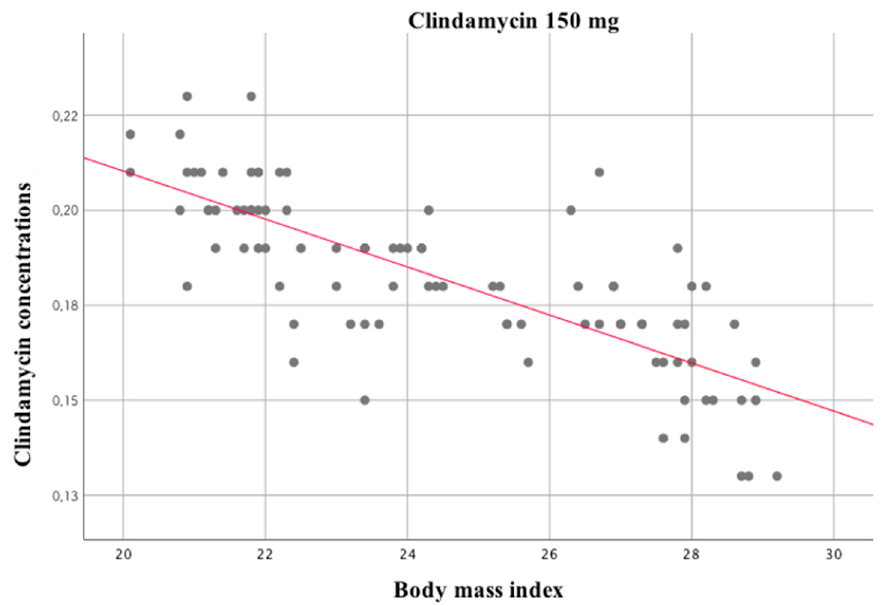
Figure 2. Correlation between the body mass index of patients receiving 150 mg of clindamycin and its concentration on the third day.